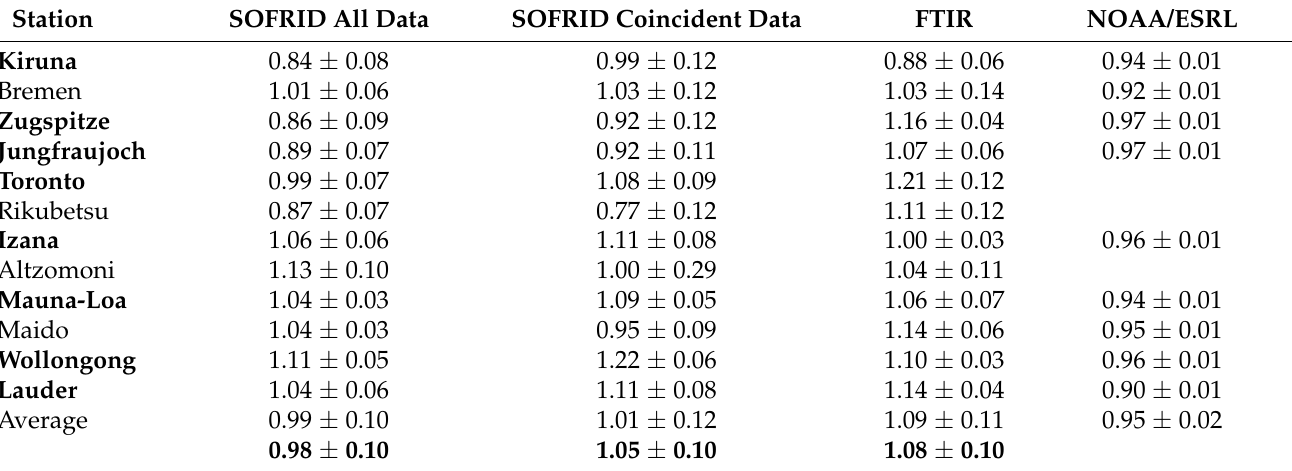
Table 6. Mid-Tropospheric N 2 O trends for SOFRID, FTIR and NOAA/ESRL data (ppbv/year). The average trend for the 8 stations with continuous 2008–2018 FTIR observations (Table 1) is given in boldface in the last line. Station SOFRID All Data SOFRID Coincident Data FTIR